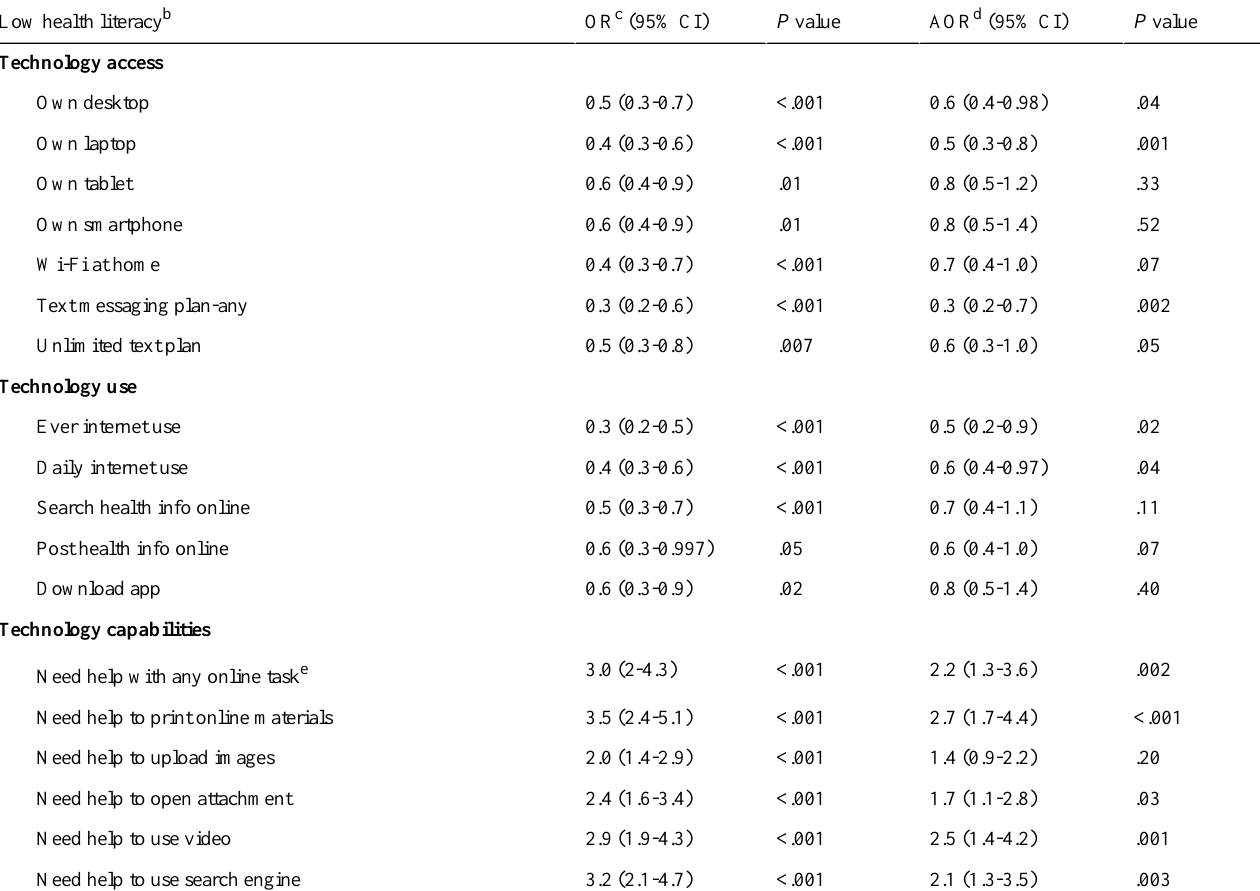
Table 1. The relationship of low health literacy and technology access, use, and capabilities a